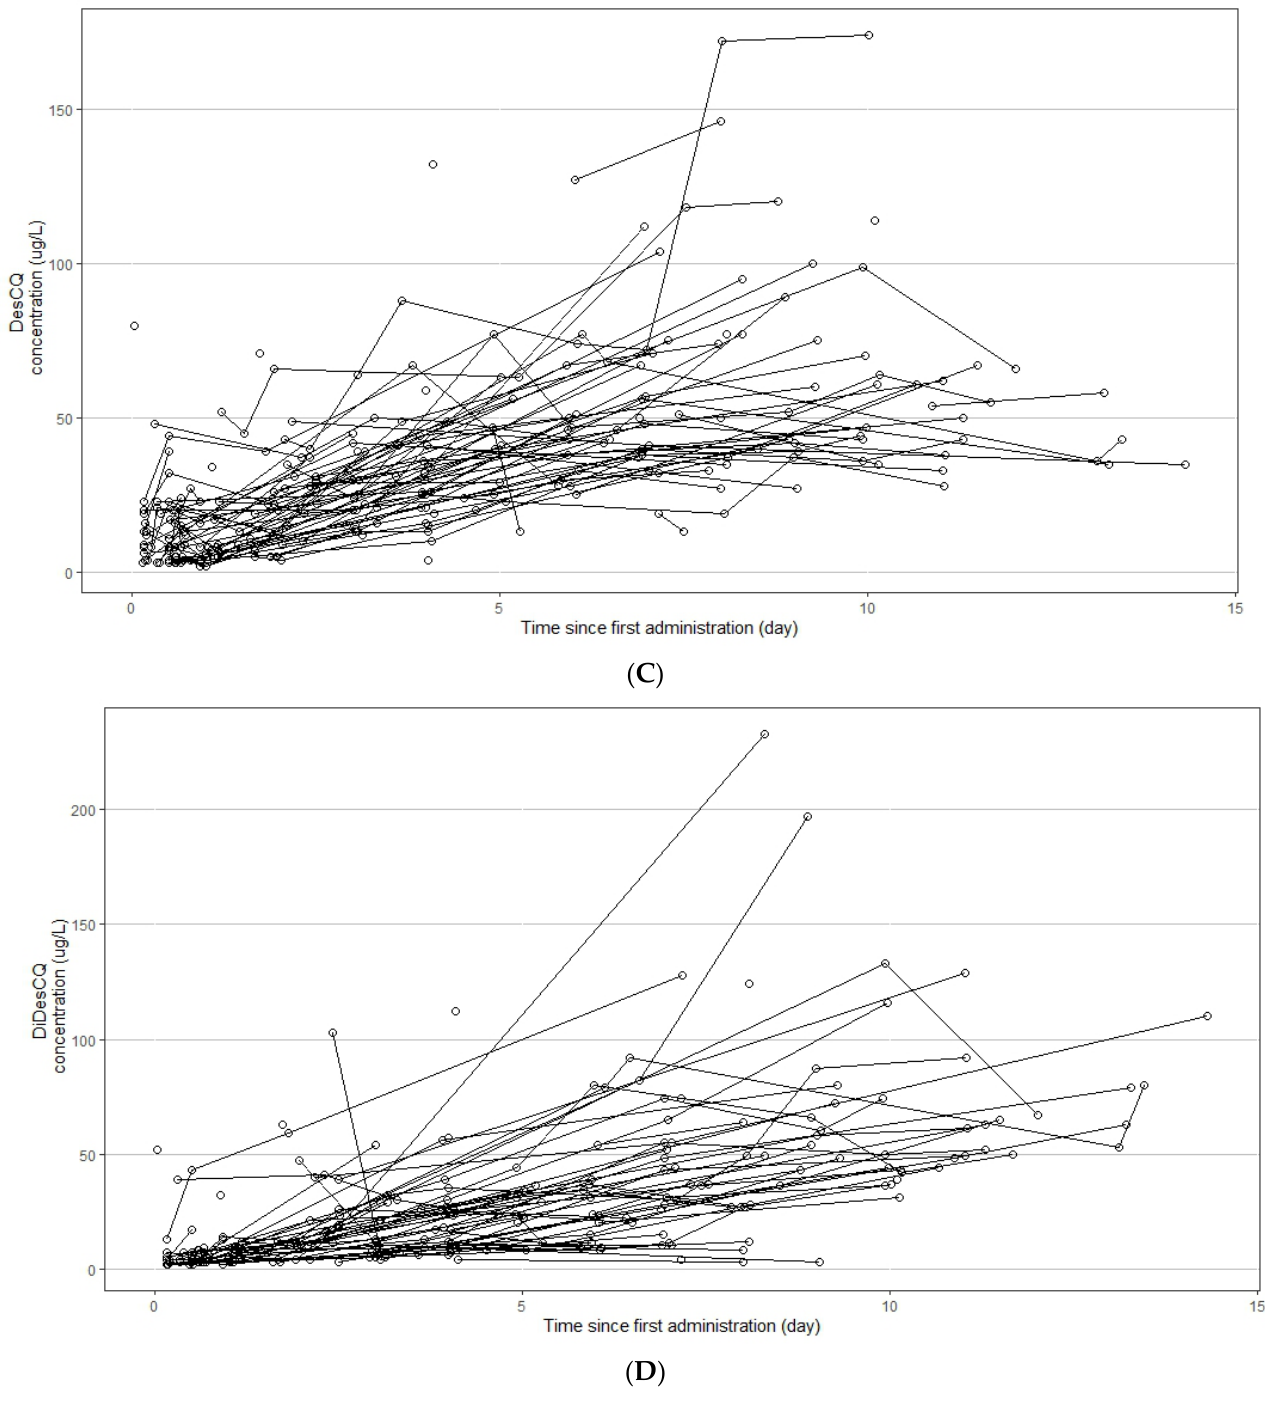
Figure 2. Concentration versus time profiles of hydroxychloroquine (HCQ, A ), desethylhydroxychloroquine (DesHCQ, B ), desethylchloroquine (DesCQ, C ), and didesethylchloroquine (DiDesCQ, D ) in COVID-19 patients. Table 2. Population pharmacokinetic parameters of hydroxychloroquine and its metabolites.